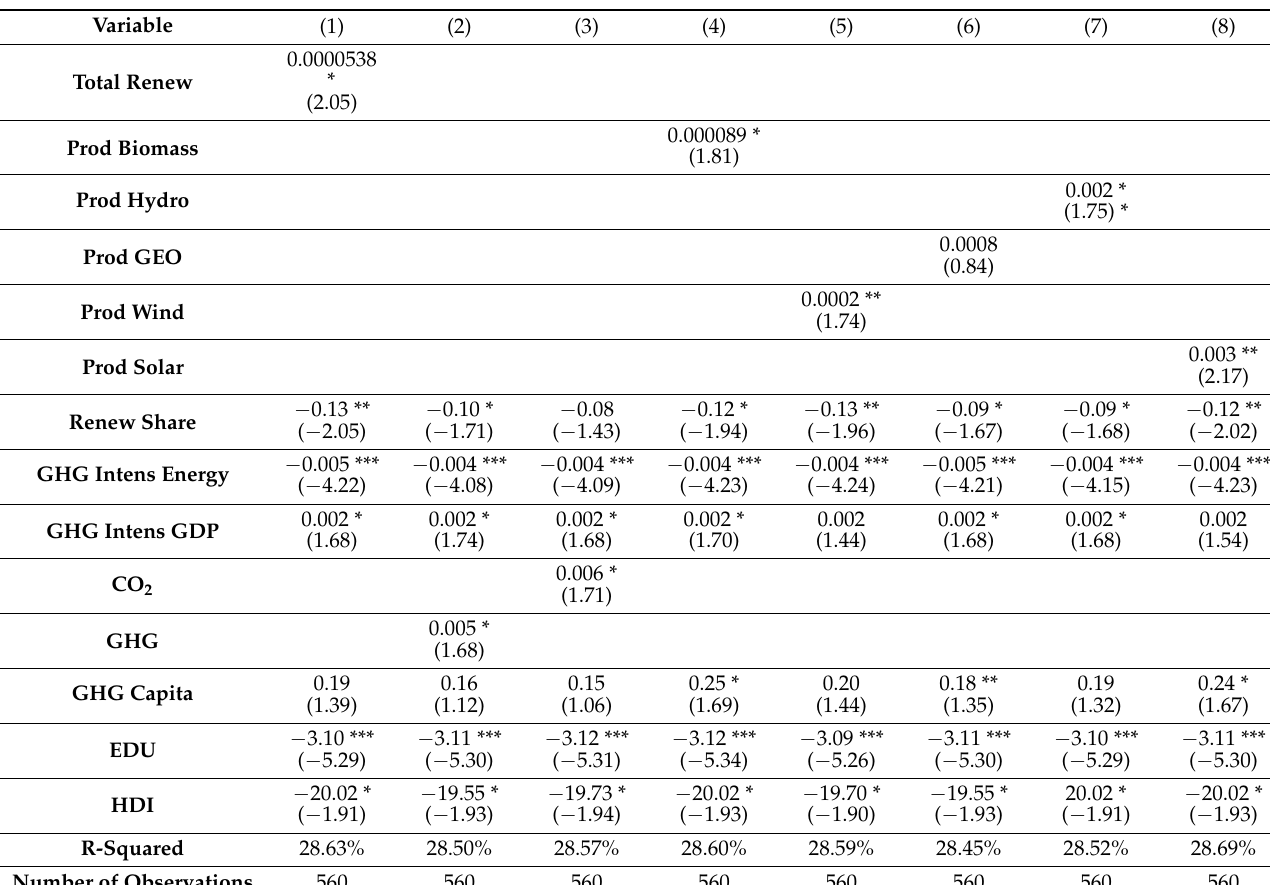
Table 4. The model estimated